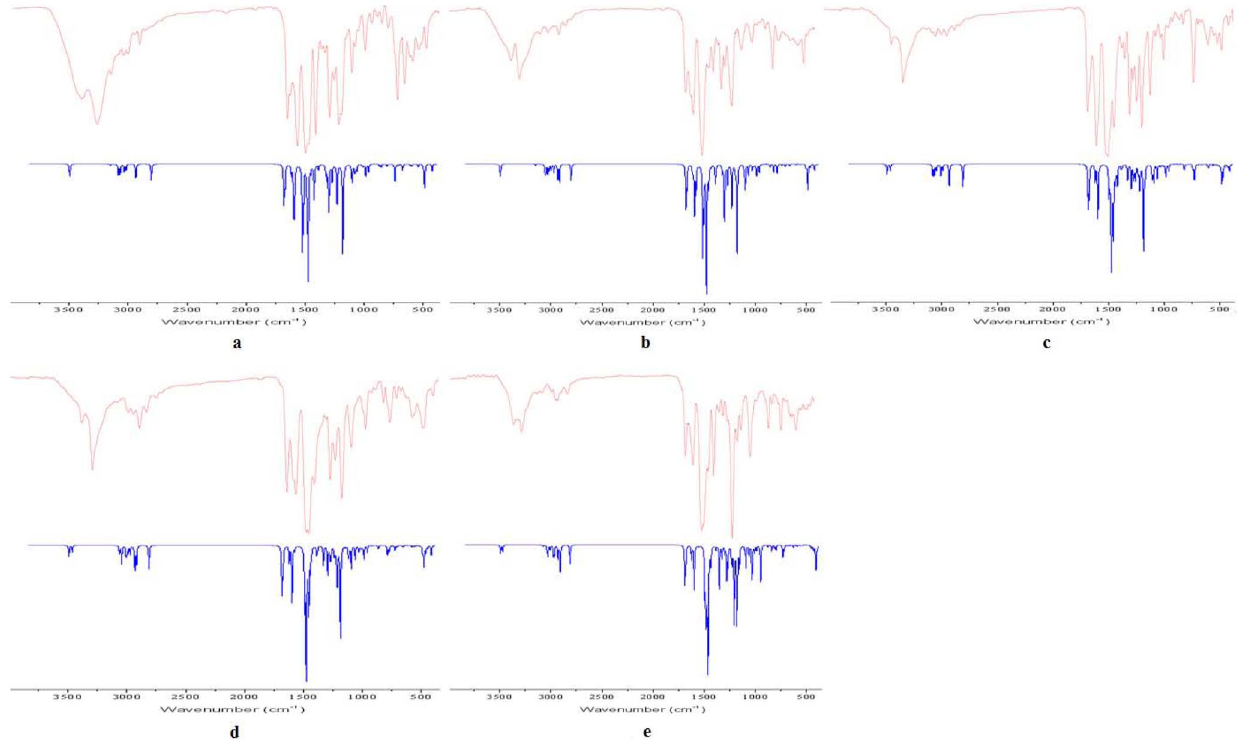
Figure 5. Experimental (Red) and simulated (Blue) Infrared spectra of a-e. doi:10.1371/journal.pone.0091361.g005 PLOS ONE |